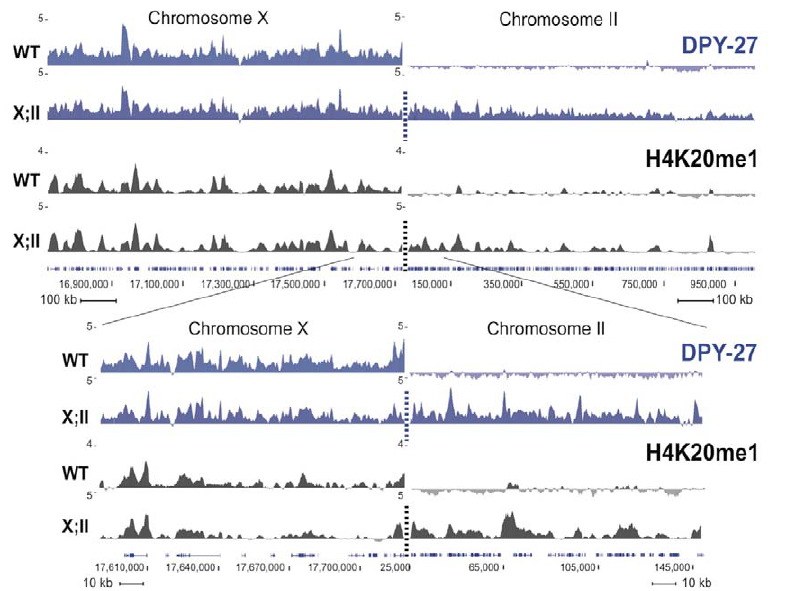
Figure 3. H4K20me1 ectopically spreads onto the autosomal region of an X;II fusion chromosome. H4K20me1 ChIPs were performed in wild-type (WT) and YPT41 mixed stage embryos. YPT41 carries a fusion of the right end of X to the left end of chromosome II. The fusion site is indicated with a dashed line. DPY-27 ChIP-chip and H4K20me1 ChIP-seq enrichment are shown in blue and black, respectively. For each track, the average of two independent biological replicates is shown as z-scores (standardized log 2 ratios of ChIP/Input signals). Genome browser views of , 2 Mb and , 200 kb spanning the fusion site are shown on the top and below, respectively.